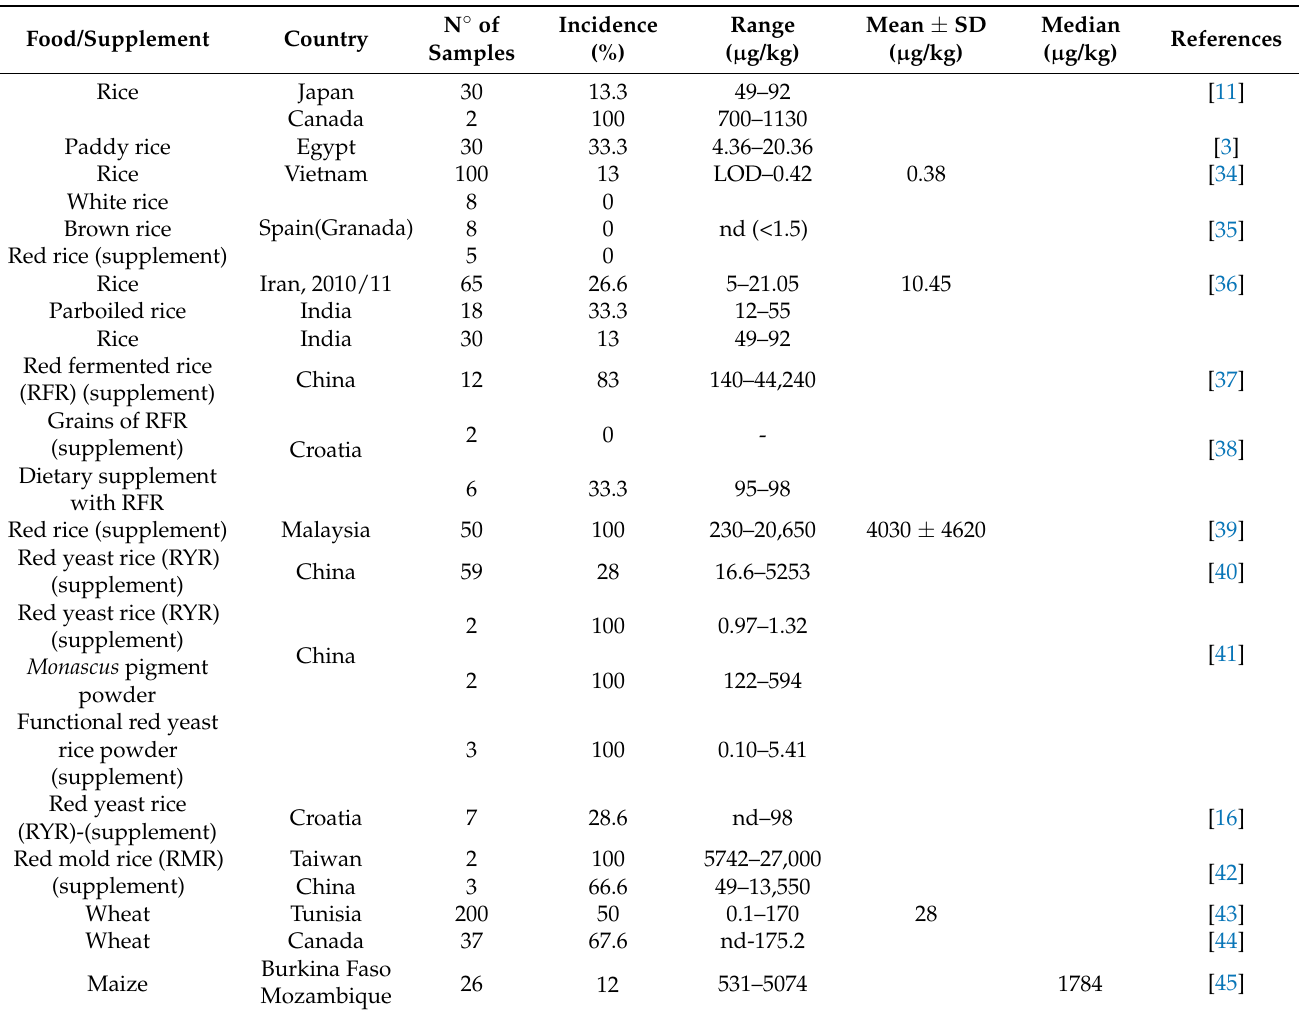
Table 1. Worldwide incidence and occurrence of CIT in foods and